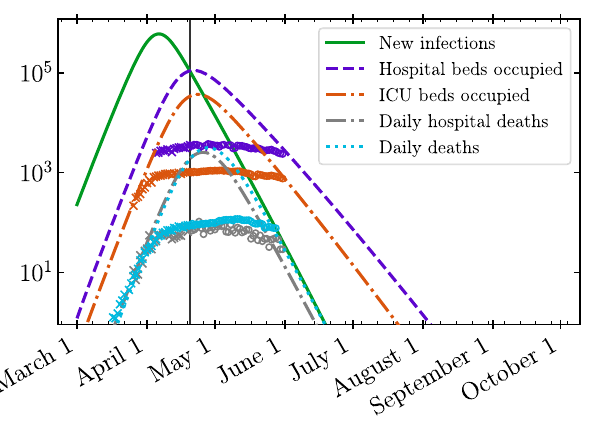
FIG. 7. Counterfactual simulation of the COVID-19 epidemic in the absence of government or population self-imposed social- distancing measures. The model is calibrated to data through April 20, 2020 (crosses); we then artificially set M ð t 1 Þ ¼ 1 , i.e., assume no mitigation ever takes place. The data from later dates (open circles) are not used in our fits, and they demonstrate the effect that real-world NPI strategies had on the epidemic. We depict the daily incidence of new infections (green, solid), the number of occupied hospital beds by confirmed or tentative COVID-19 patients (purple, dashed), the number of ICU beds occupied by confirmed COVID-19 patients (orange, dot-dashed), and total daily deaths of COVID-19 patients (light blue, dotted). We remove reporting artifacts by plotting daily-death data smoothed by a 7-day running average.